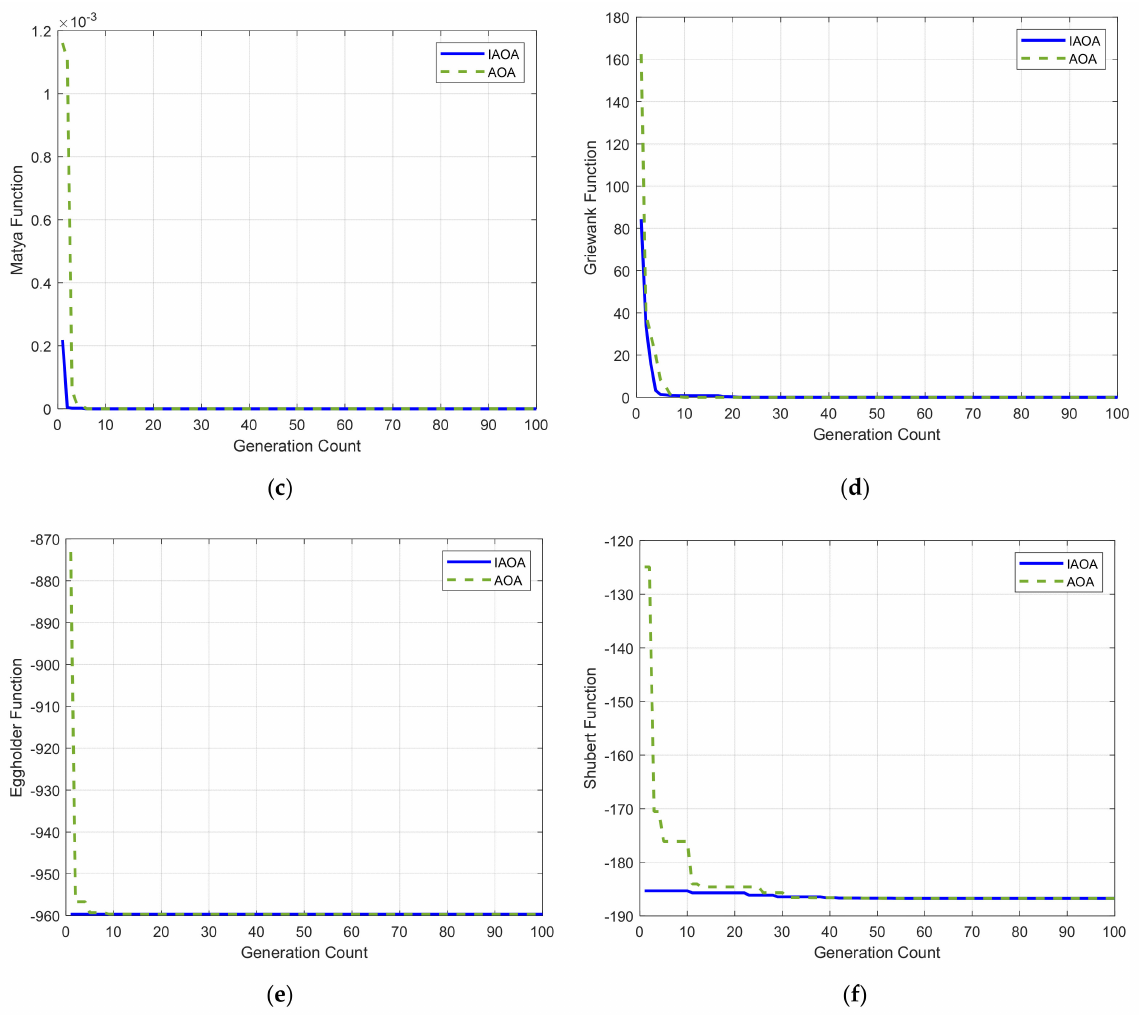
Figure 9. Convergence plots of benchmark functions. ( a ) Convergence characteristics of Beale func- tion. ( b ) Convergence characteristics of Powell function. ( c ) Convergence characteristics of Matyas function. ( d ) Convergence characteristics of Griewank function. ( e ) Convergence characteristics of Eggholder function. ( f ) Convergence characteristics of Shubert